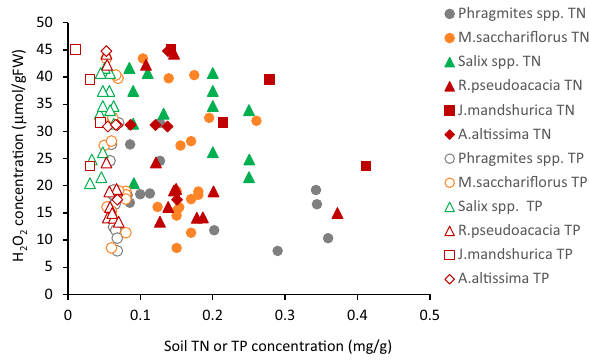
Figure 5. Relationship between leaf H 2 O 2 concentration and soil TN or TP